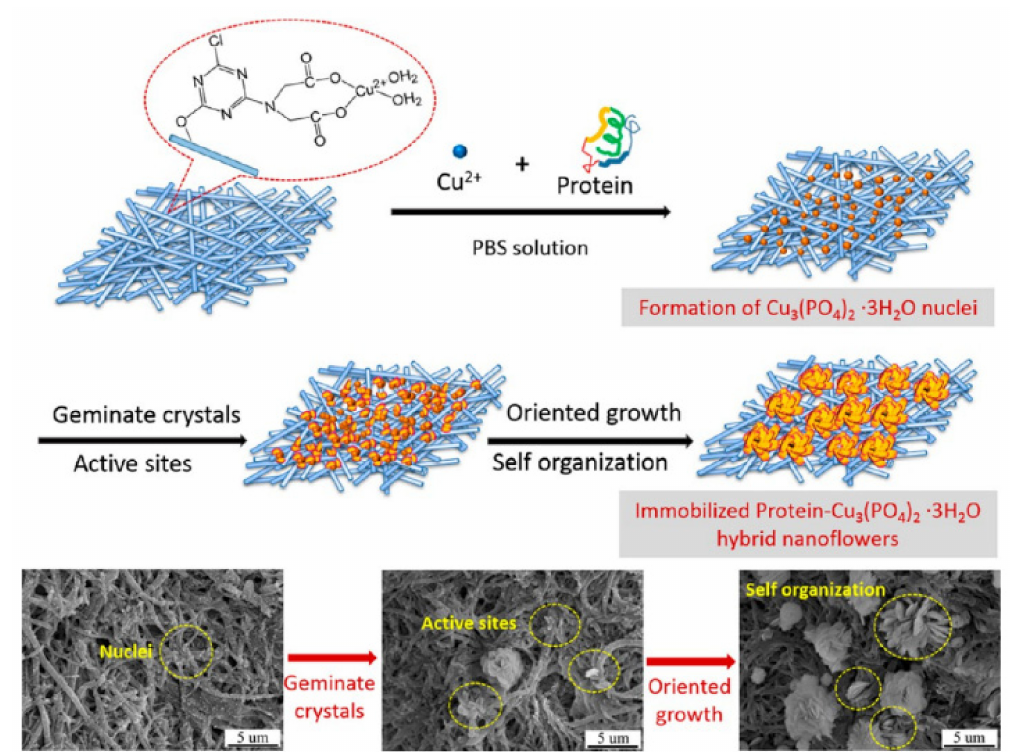
Figure 11. The growing process copper − protein hNFs. Reprinted from [42] with permission from the American Chemical Society. Copyright © 2021 American Chemical Society.